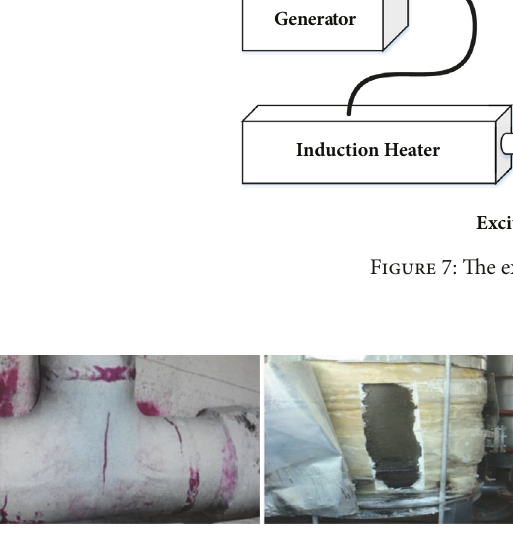
Figure 8: The damaged pneumatic pressure device.